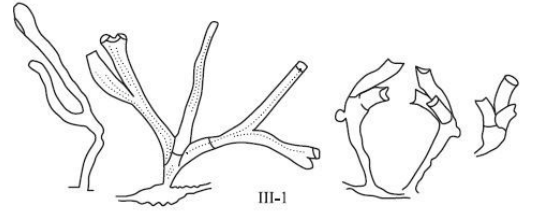
Figure 6. Juvenile deformed shoots of D. pumila (group III-1).